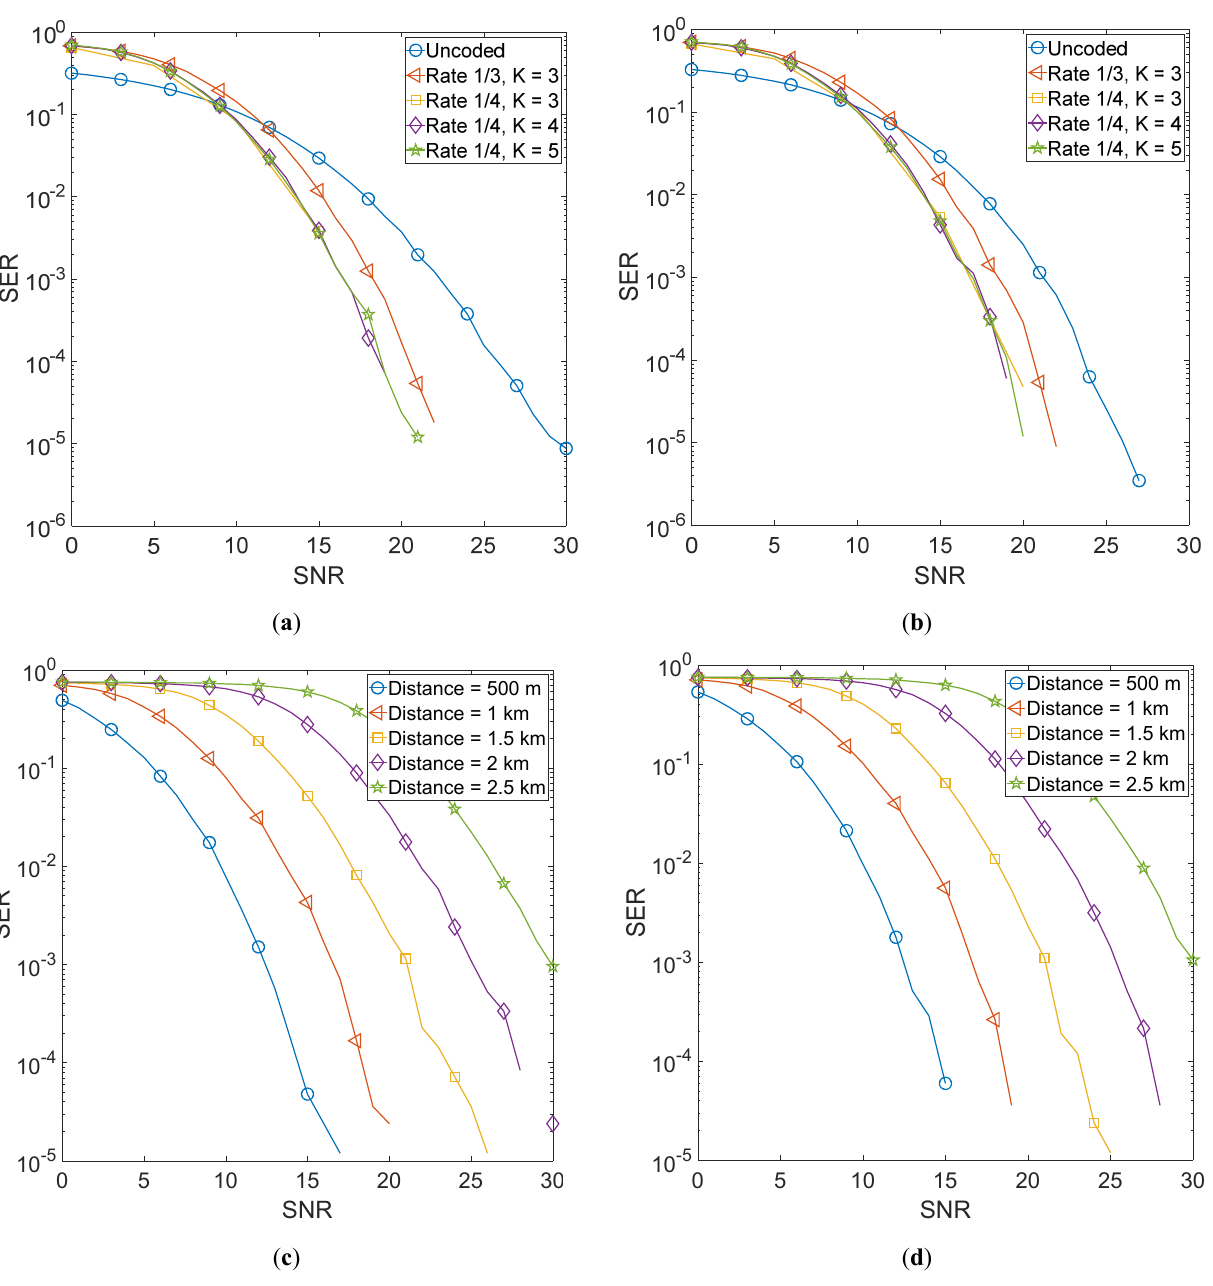
Figure 5. Convolutionally encoded 4QAM-GFDM schemes. ( a ) Comparison of selected convolutional codes with MF equalizer. ( b ) Comparison of selected convolutional codes with ZF equalizer. ( c ) Error performance as a function of Tx-Rx distance for rate 1/4, constraint length 5 scheme with MF equalizer. ( d ) Error performance as a function of Tx-Rx distance for rate 1/4, constraint length 5 scheme with ZF equalizer.